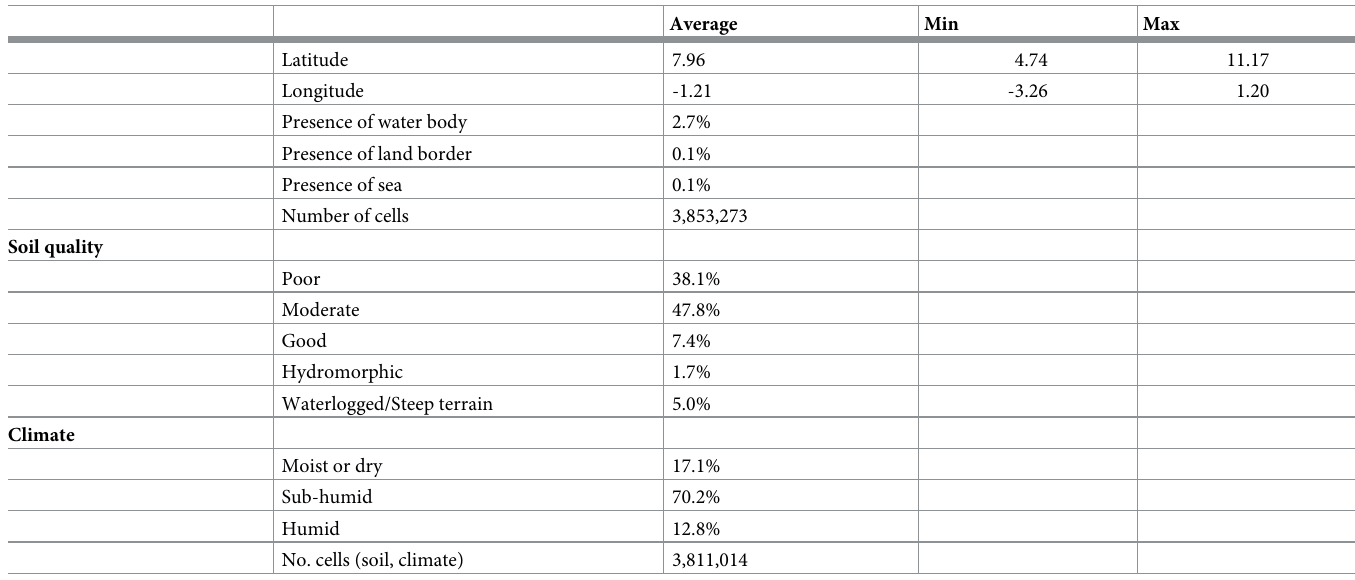
Table 3. Time-invariant features of cells.